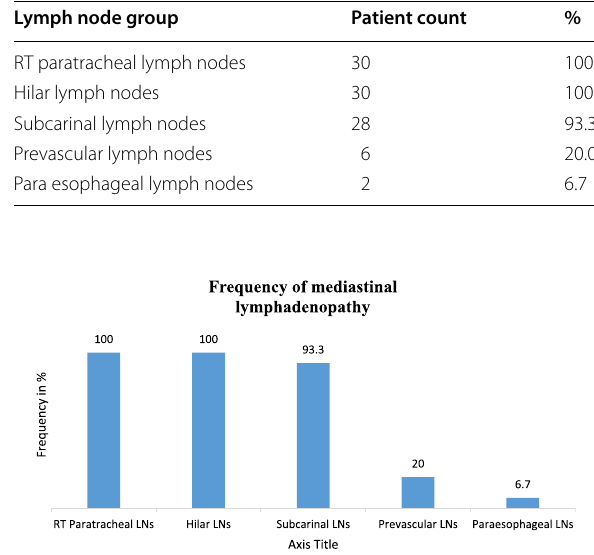
Fig. 1 Distribution of the lymph nodes in the sarcoid